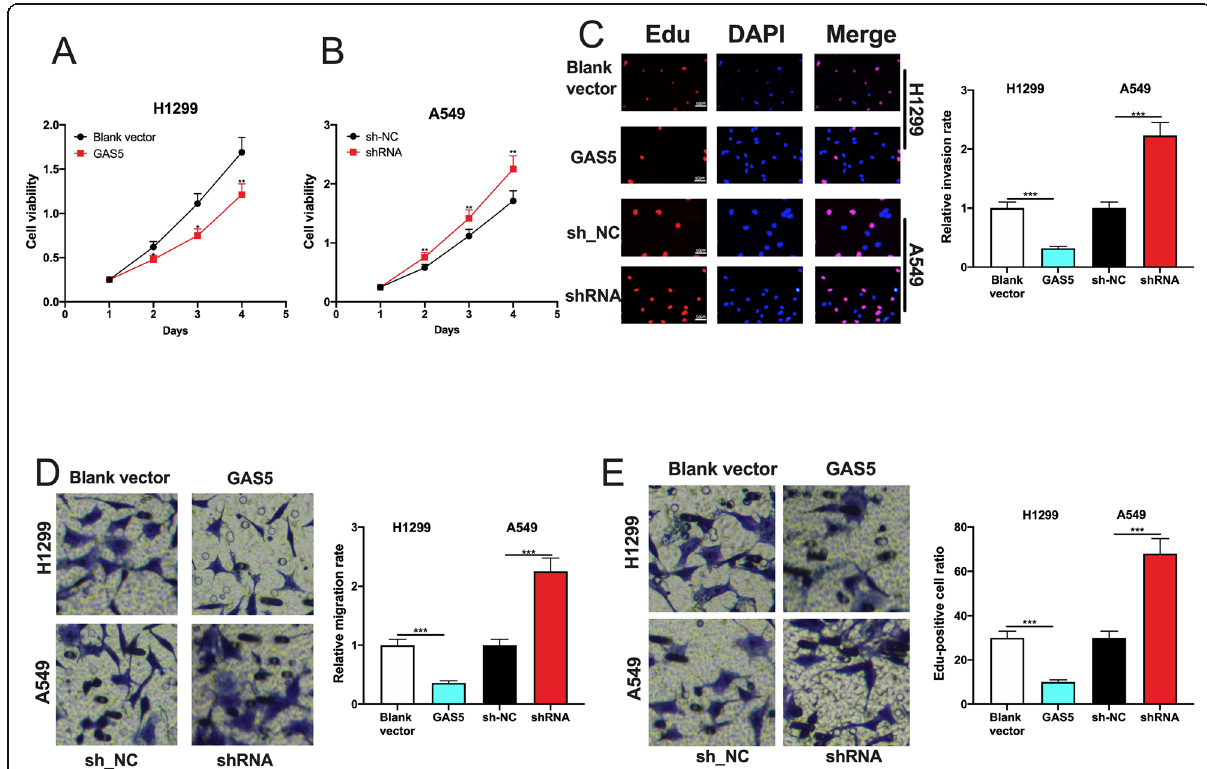
Fig. 2 Effects of GAS5 on NSCLC cells. a , b CCK-8 was executed to detect the effects of overexpression and knockdown of GAS5 on the viability of H1299 and A549 cells, respectively. c EdU experiment was executed to detect the effects of overexpression and knockdown of GAS5 on the proliferation of H1299 and A549 cells, respectively. d , e Transwell was used to analyze the effects of overexpression and knockdown of GAS5 on the migration and invasion of H1299 and A549 cells, respectively. *, **, *** represent P < 0.05, P < 0.01, P <